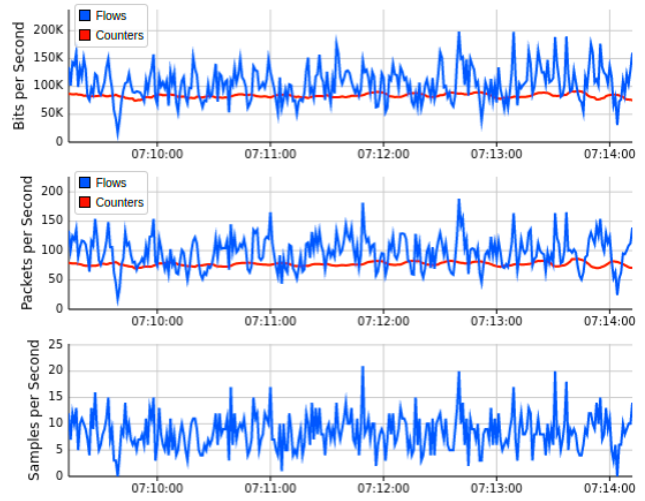
Figure 15. Performance dashboard for OF switches during normal traffic (T2).